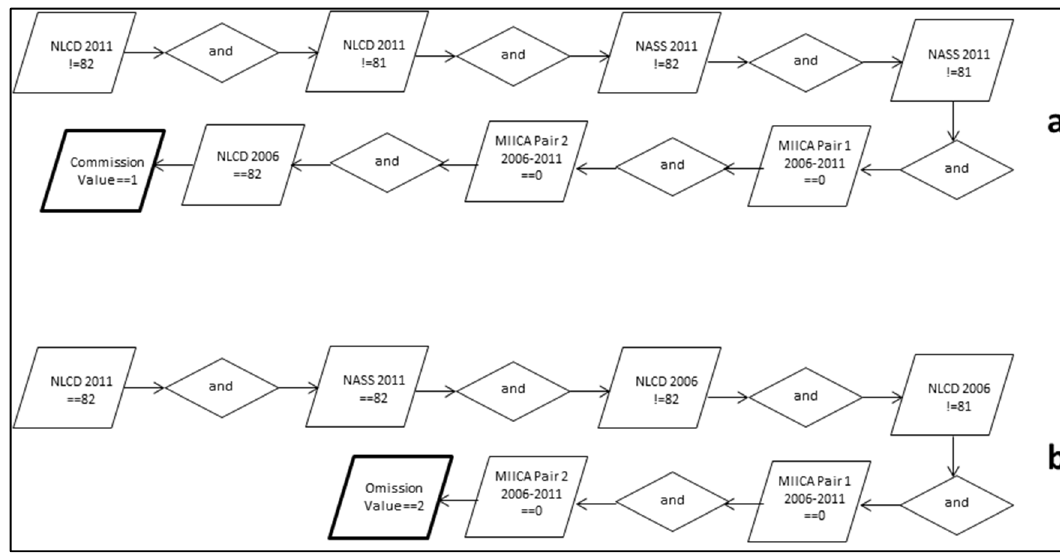
Figure 3. ( a ) Flowchart of the developed method for identifying potential commission errors in the NLCD 2006 Cultivated Class; and ( b ) flowchart of the developed method for identifying potential omission errors in the NLCD 2006 Cultivated Class.